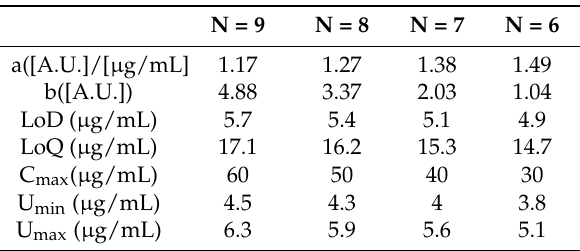
Table 3. Numerical values of calibration lines, uncertainty band, limits of detection and quantification and measuring intervals for the given example.